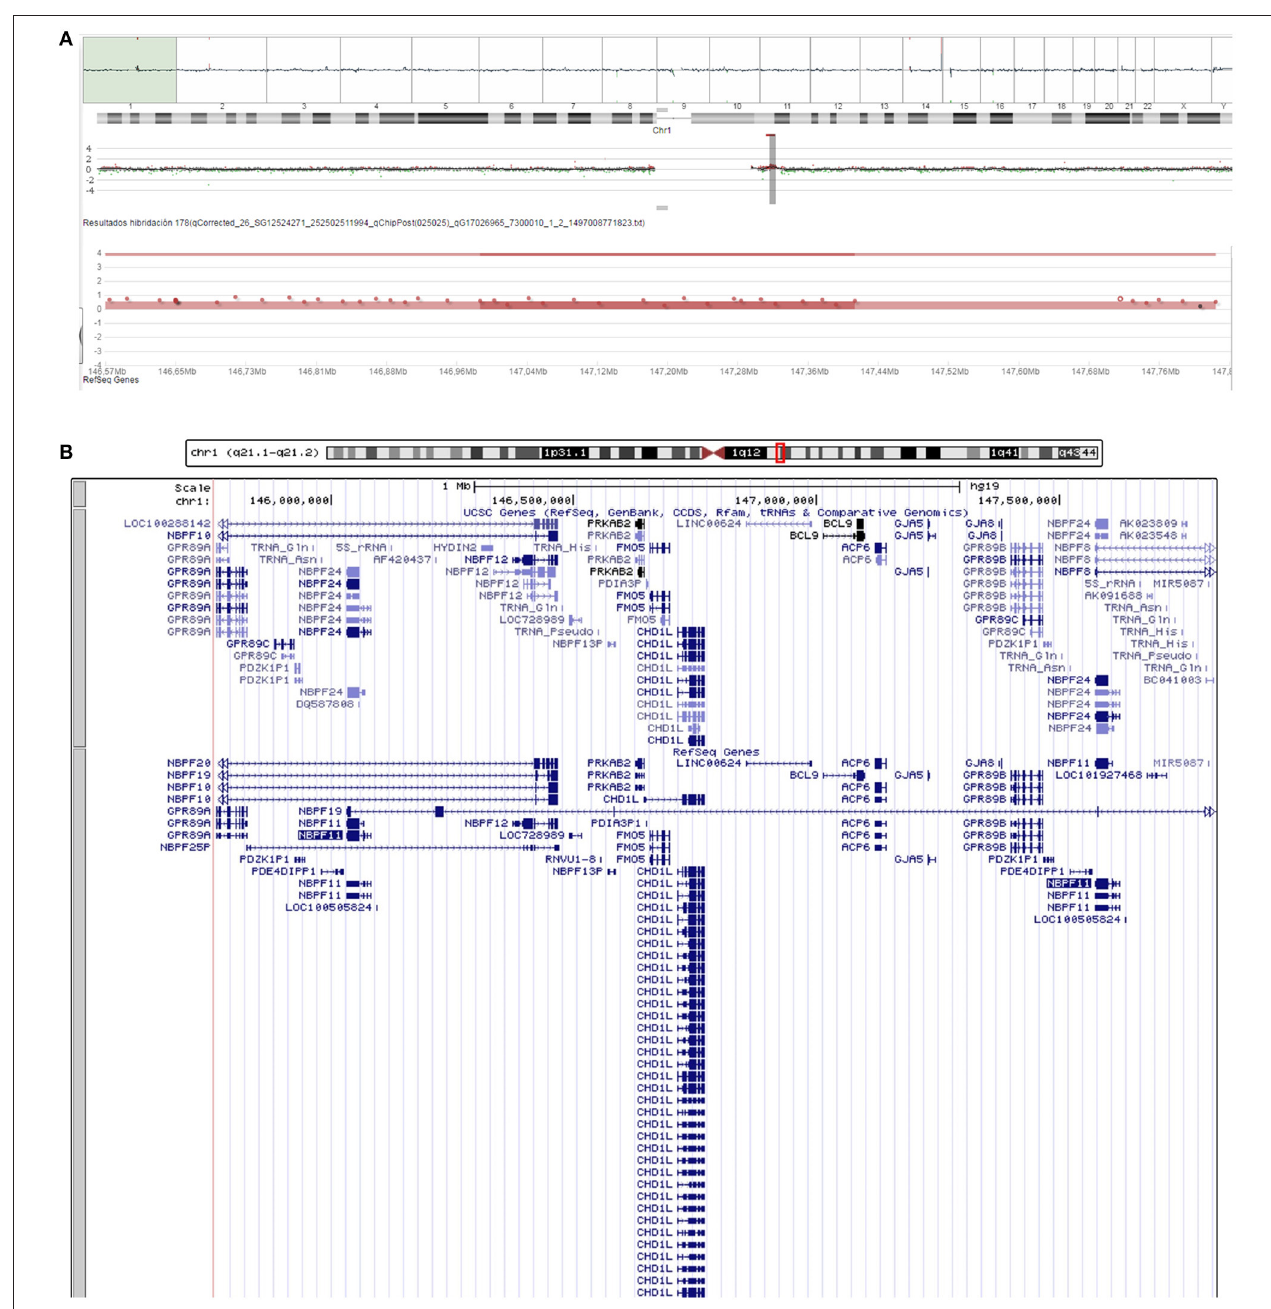
FIGURE 2 | Chromosomal alterations found in our proband. (A) Screen capture of the array-CGH of the proband’s chromosome 1 showing the microduplication at 1q21.1. (B) Screen capture of the UCSC Genome Browser (https://genome.ucsc.edu/) showing the genes duplicated in the